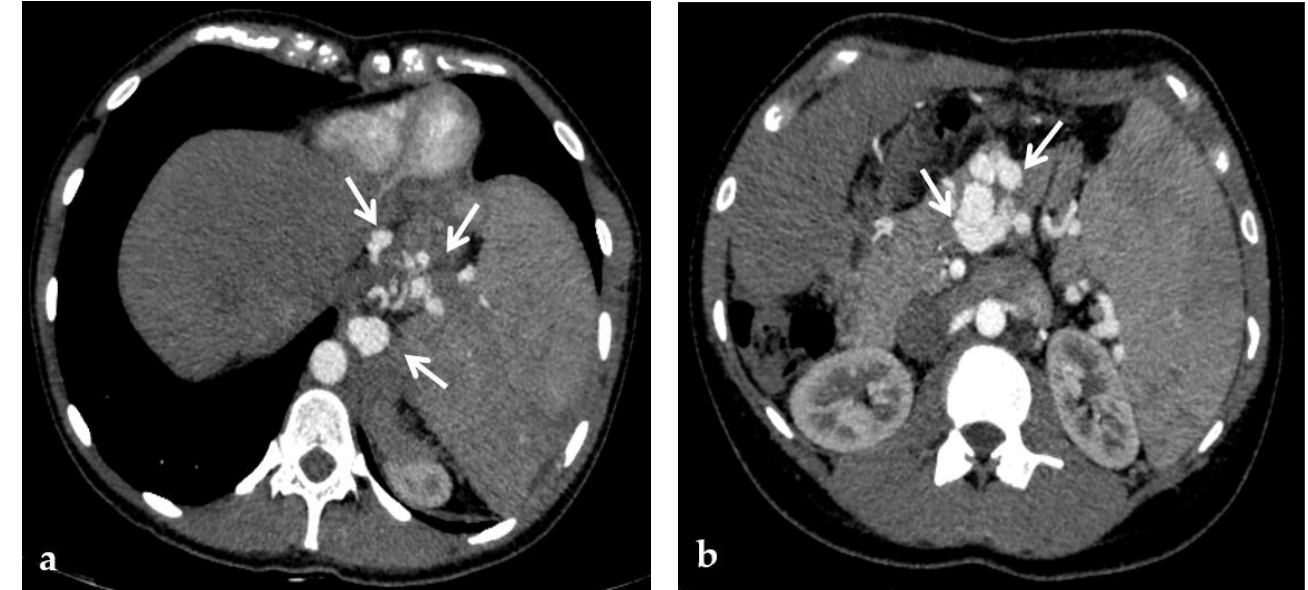
Figure 5. CT of a 21-year-old female who underwent deceased-donor orthotopic liver transplantation (split II-III) for biliary atresia, complicated by the development of portal vein thrombosis and cavernous transformation, who presented with melena and hematemesis 12 years after transplantation. ( a ) Arterial phase axial CT images show multiple arterial aneurysms of the diaphragmatic and gastric arteries, with hypertrophic submucosal vessels in the gastric fundus (arrows). ( b ) Arterial phase axial CT image also shows multiple large arterial aneurysms of the splenic artery (arrows).